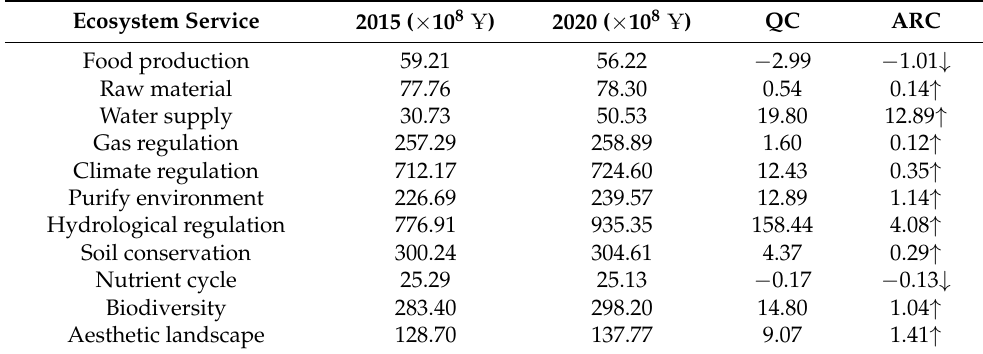
Table 8. Change of ESV Components in the SAHMHER from 2015 to